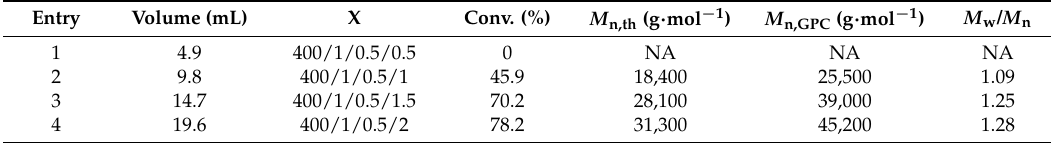
Table 2. Effect of the amount of ligand, N,N,N ′ ,N ″ ,N ″ -Pentamethyldiethylenetriamine (PMDETA) on the AGET ATRP with thiol-functional cell paper as the reducing agent.